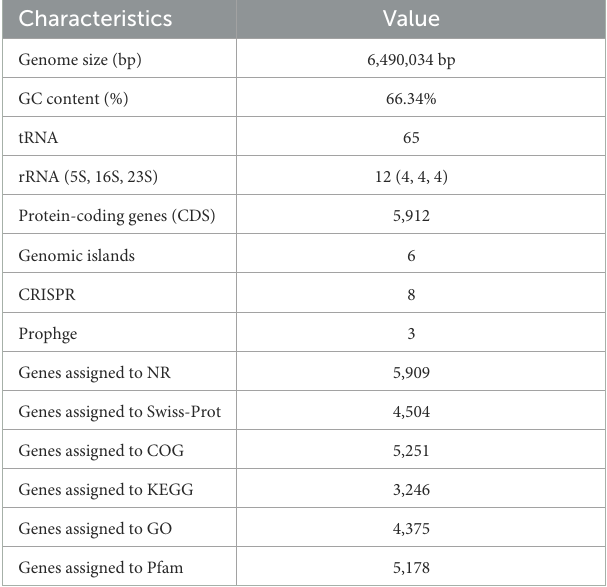
TABLE 4 Genome characteristic of endophytic strain Pseudomonas aeruginosa DJ06.